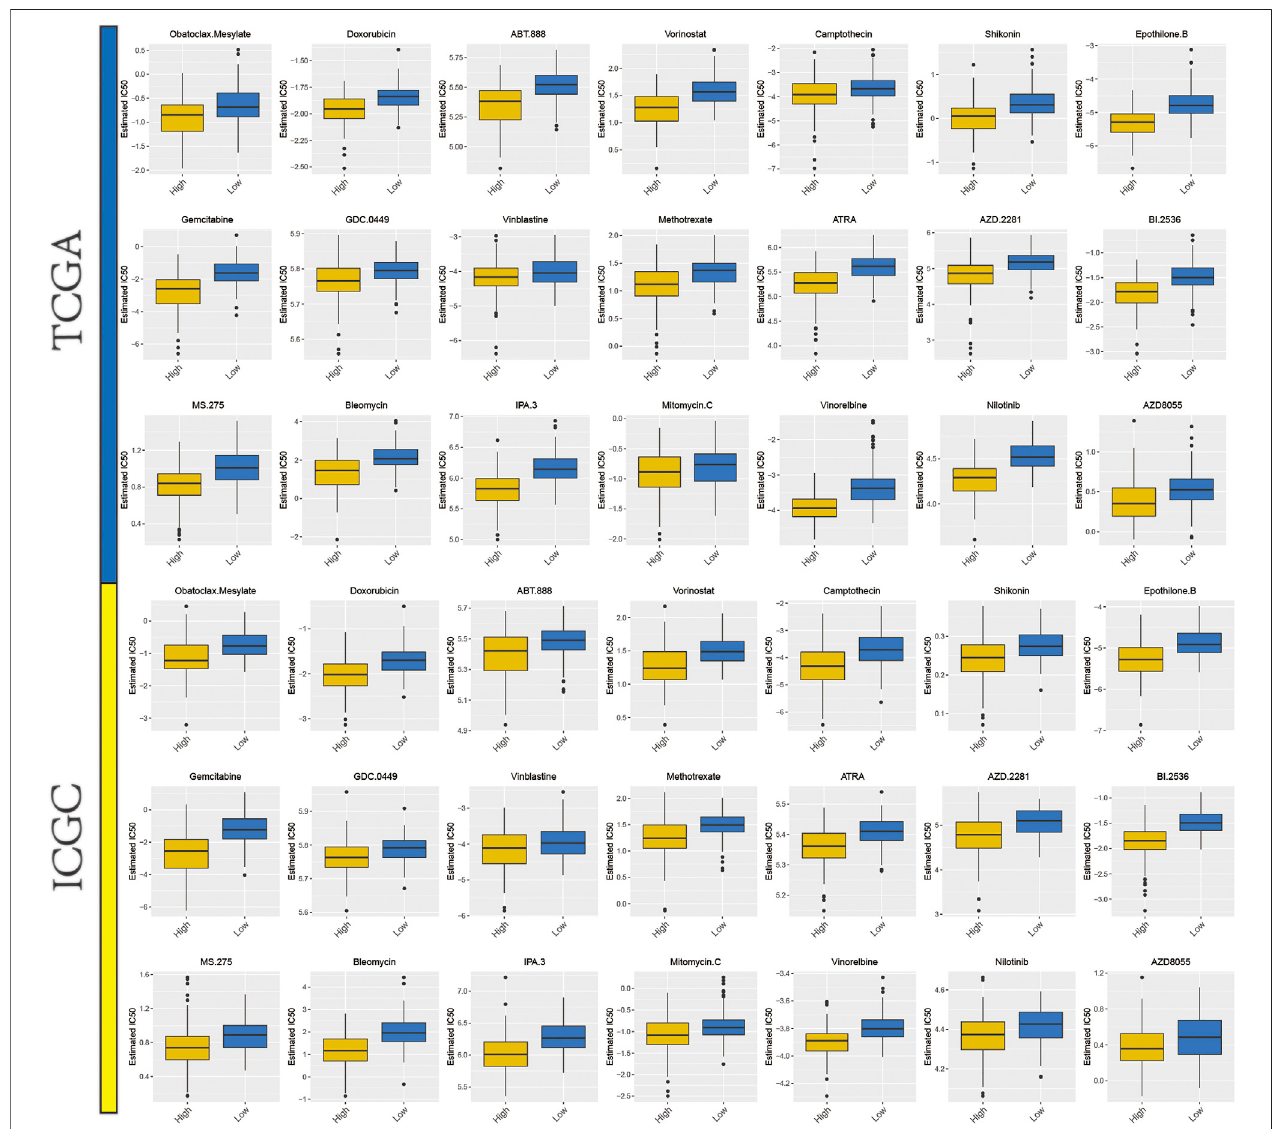
FIGURE 8 | A total of 21 potential therapeutic drugs in HCC with differential IC50 between high- and low-mitophagyscore groups.